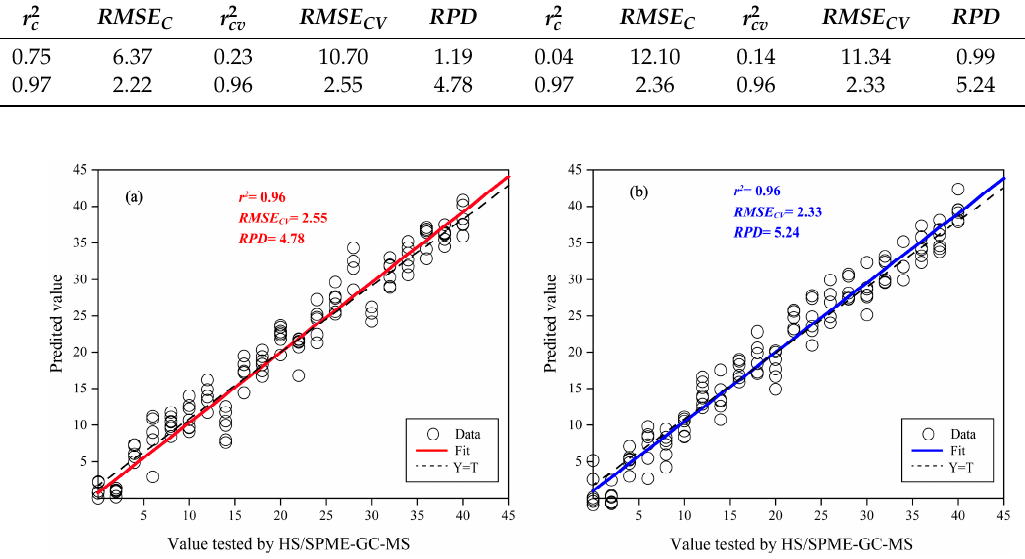
Figure 5. The results of the best prediction model for Rose Oxide . ( a ) The model wines; ( b ) the de-aromatic wines. Table 5. Results of full-band and joint interval modeling of model wine and de-aromatic wine.